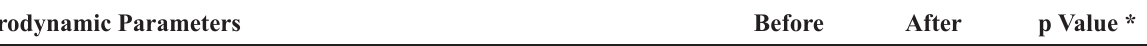
Table 1 – Urodynamic parameters before and after botulinum toxin A injection. Urodynamic